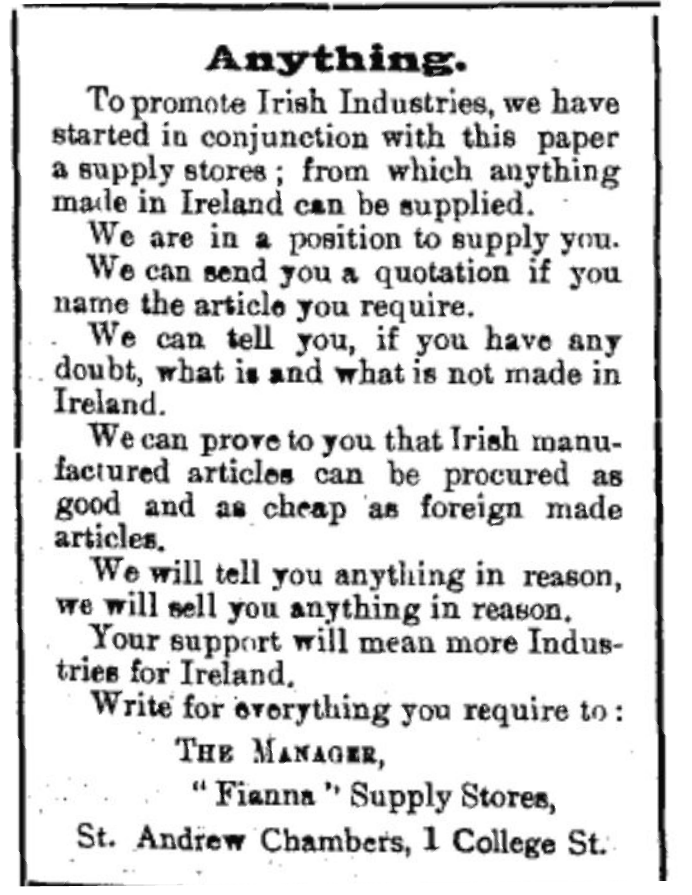
The editorial board of Fianna stating its unconditional support for Irish Industries. From Fianna , 2.4 (October 1915), 4. Author’s